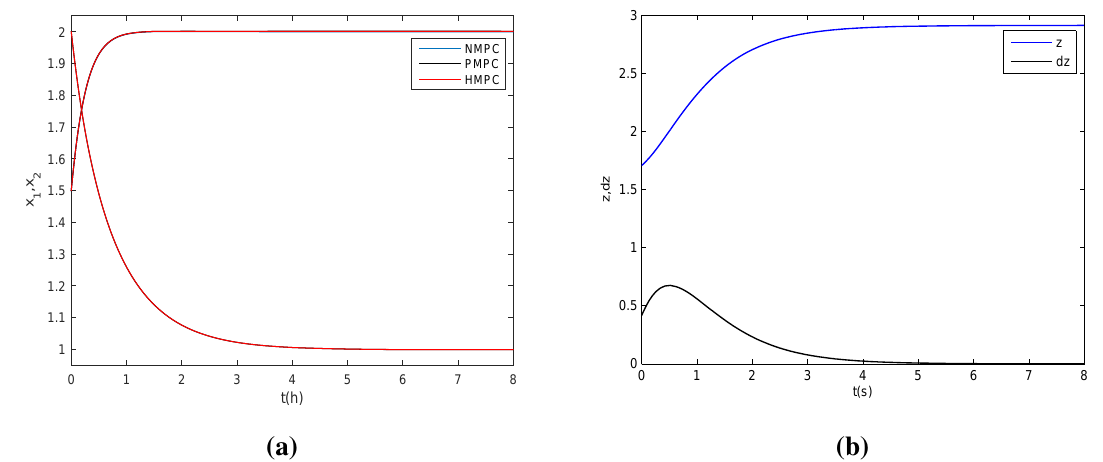
Figure 4. Simulation result with resolution m = 16. ( a ) Closed loop state trajectory; ( b ) flat output